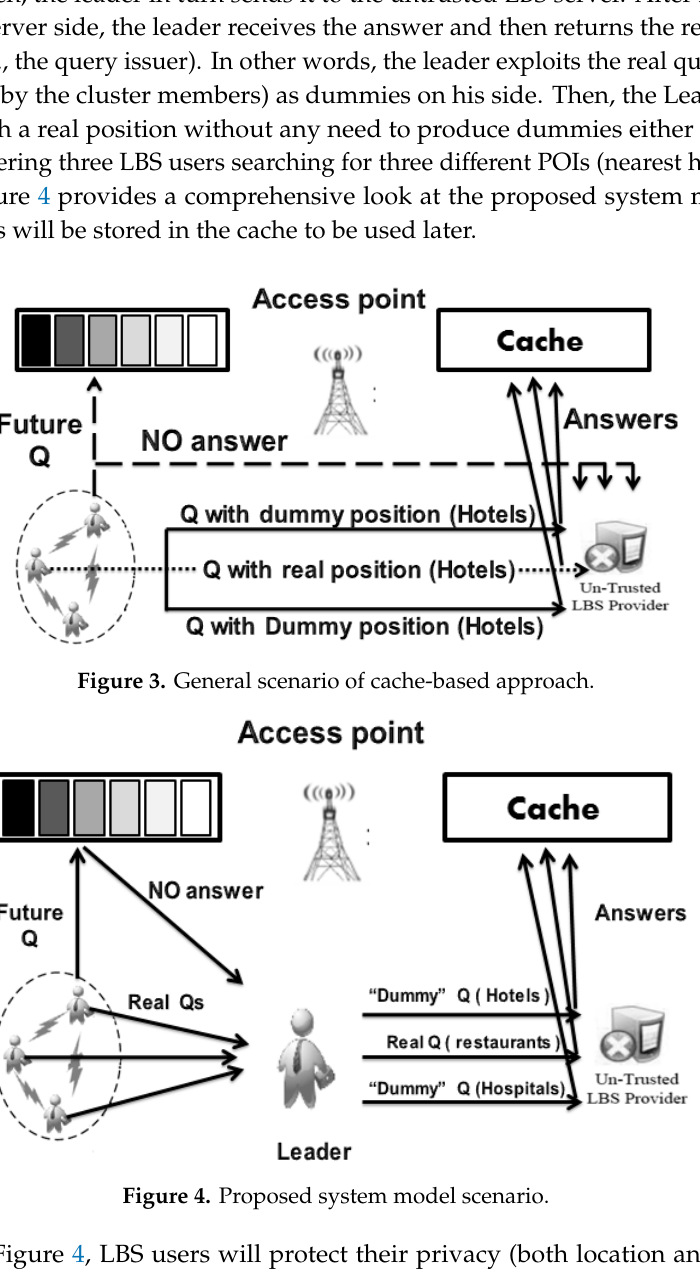
Figure 3. General scenario of cache-based approach.